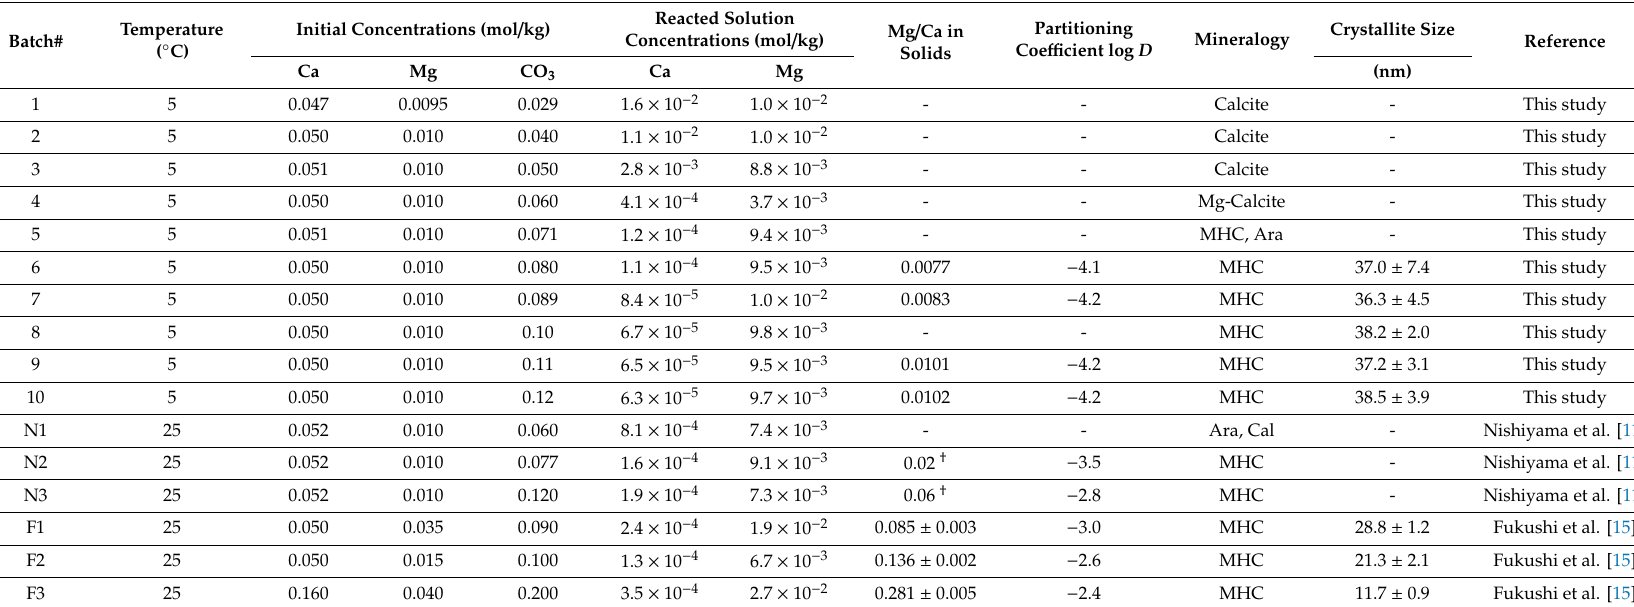
Table 1. Summary of the synthesis experiments conducted in the present study and by Nishiyama et al. [11] and Fukushi et al.